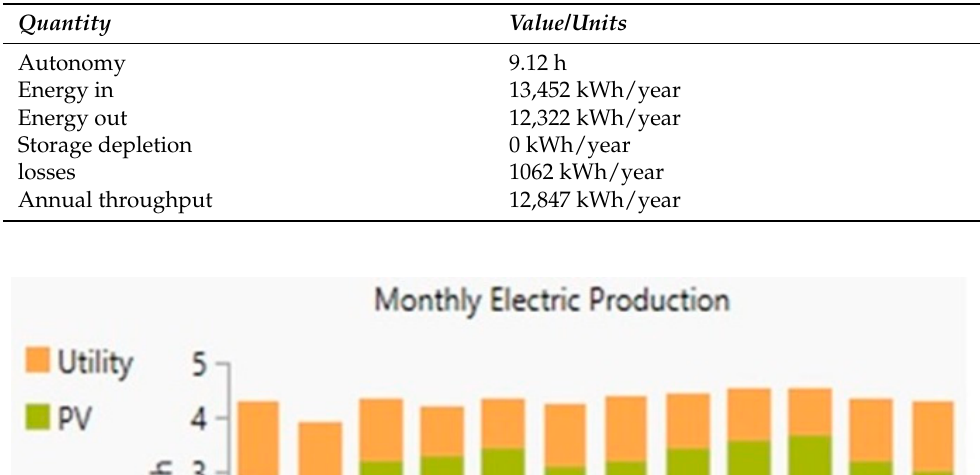
Figure 19. SOC of the BES for System 2 during an outage. Table 9. BES Result.